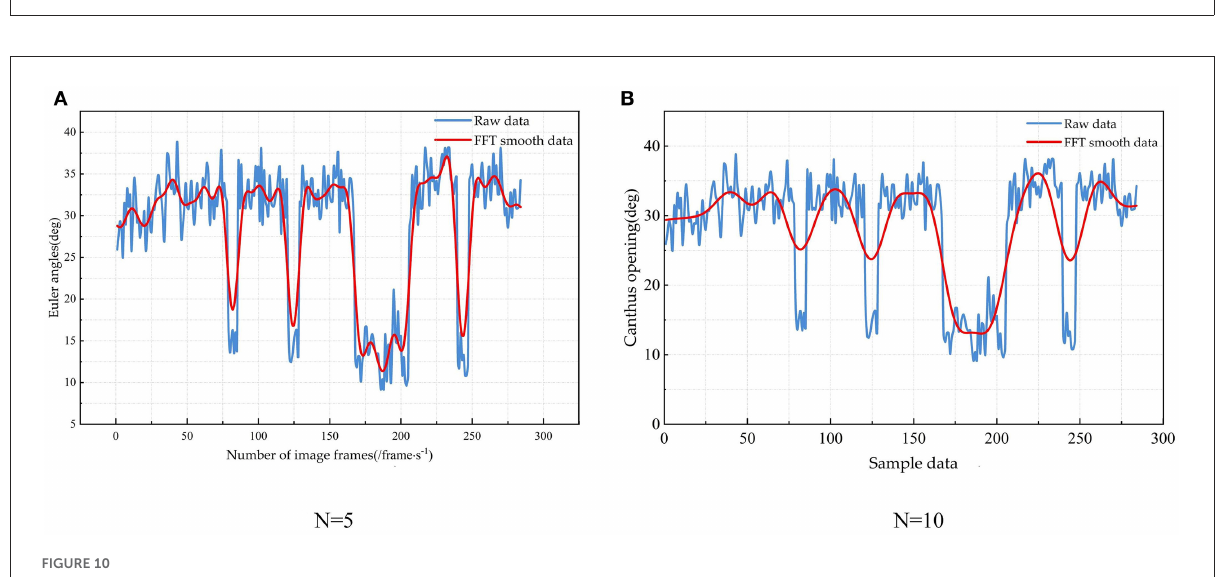
FIGURE9 Head pose estimation results of simulated experiment (A) and real vehicle experiment (B) .